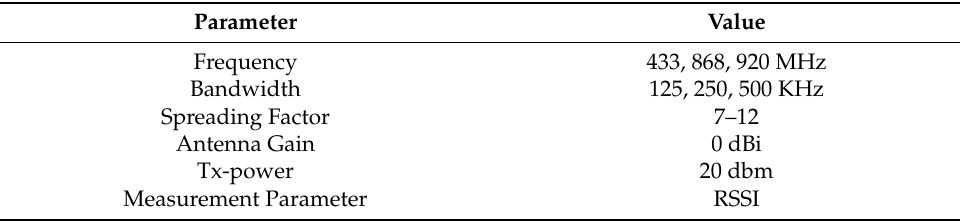
Figure 1. LoRa measurement equipment. Table 1. LoRa